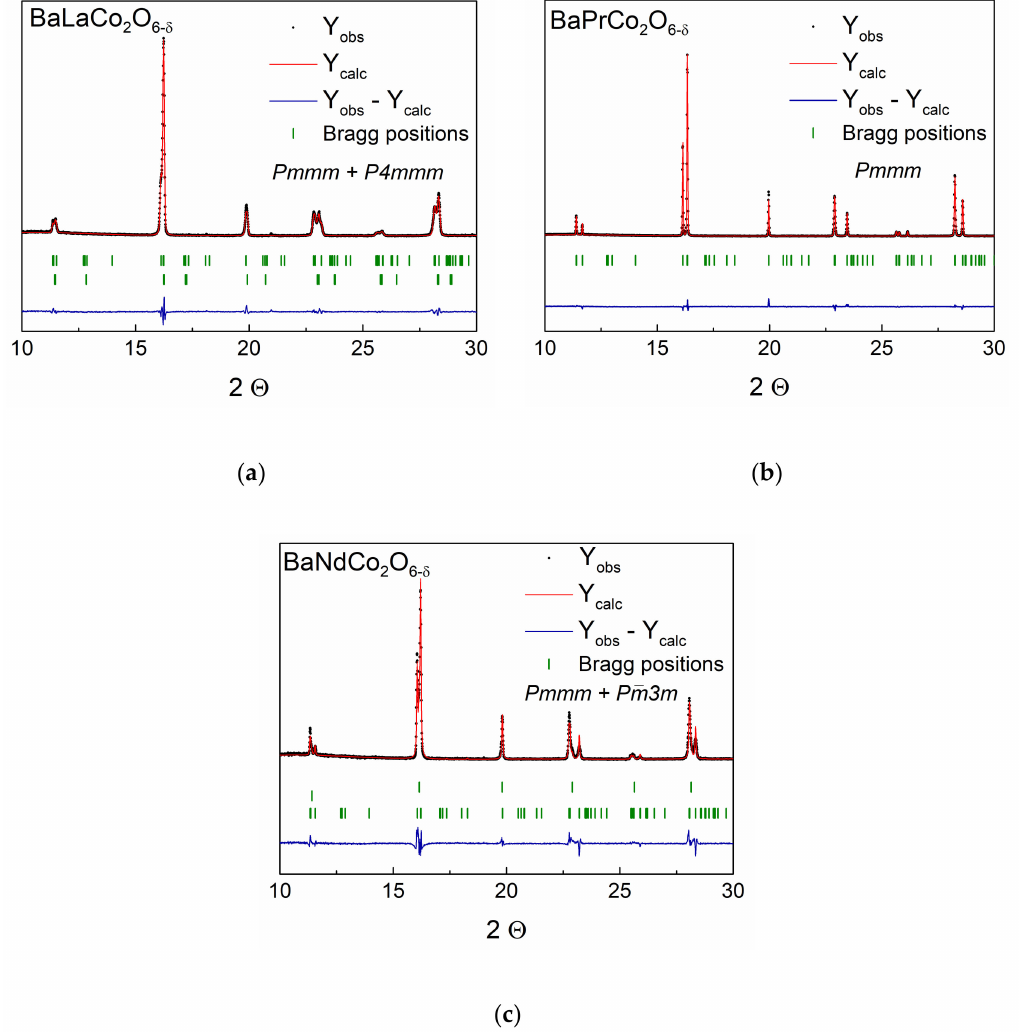
Figure 3. Observed (dotted lines), calculated (solid lines), and di ff erence (bottom) SR-PXD for BLC ( a ), BPC ( b ), and BNC ( c ) at